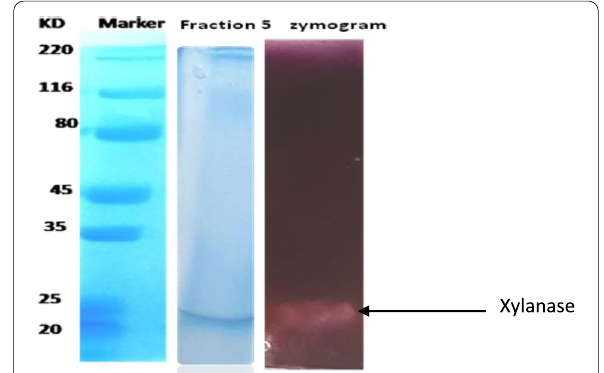
Fig. 3 SDS-PAGE and zymogram analysis of purified xylanase